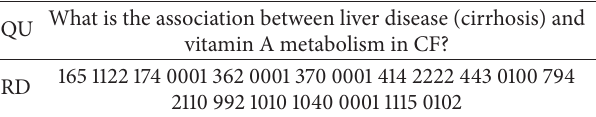
Table 1: A sample of a MEDLINE document. Table 2: A sample of query with its relevant documents and relevance